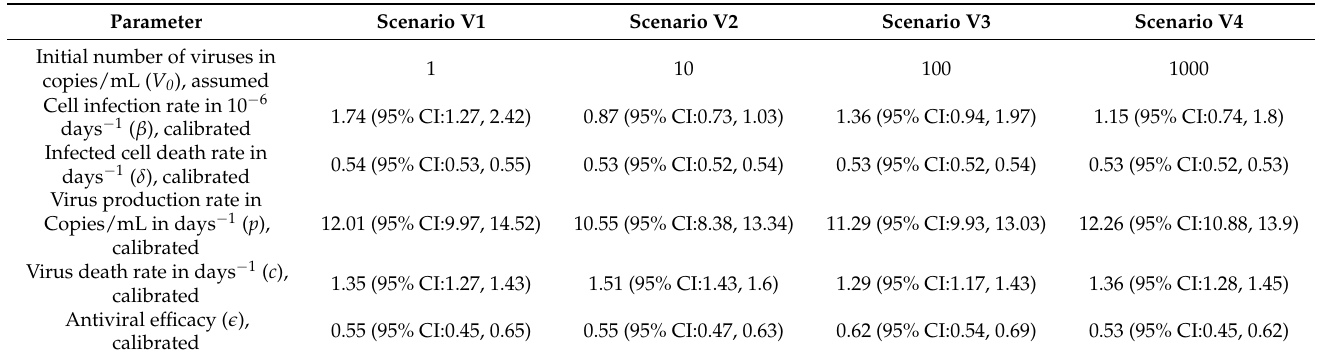
Table 2. Sensitivity analysis of antiviral efficacy by varying initial viral load. We conducted the sensitivity analysis of parameter calibration by varying the initial number of viruses in copies/mL from 1 to